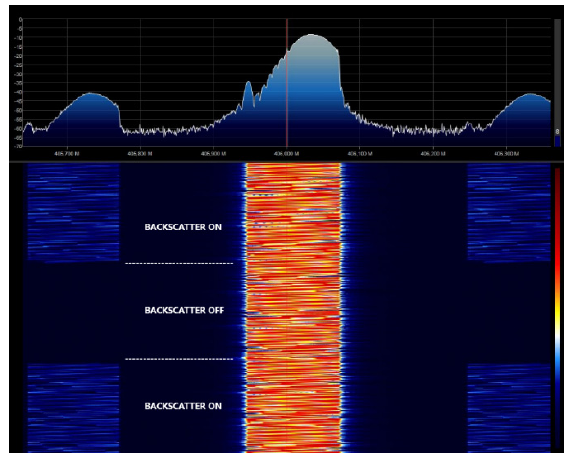
Figure 3. Measured spectrogram with the backscatter enabled and disabled for SF = 12, BW = 125 kHz.